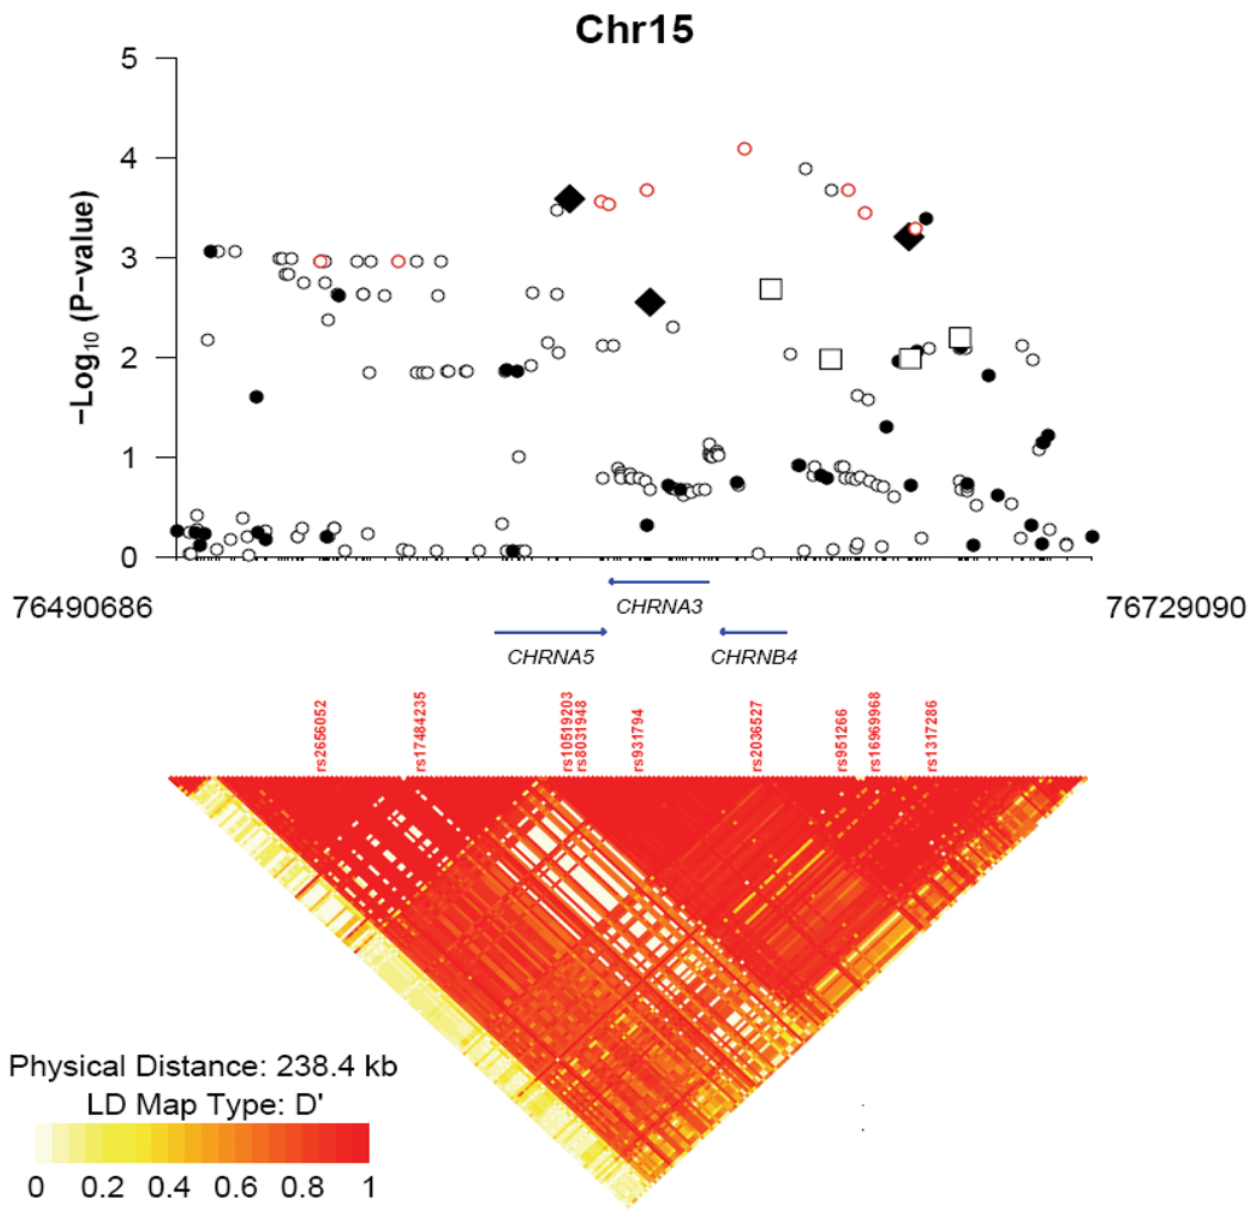
Figure 3. 2 log 10 p-values for association with number of cigarettes smoked per day (CPD) for SNPs in the chr15q25.1 region. P- values are based on the combined evidence for association from both PLCO and NHS. Filled symbols denote genotyped SNPs; open symbols denote imputed SNPs. Black diamonds (squares) denote SNPs associated with continuous (binary) CPD in previous reports. Red circles denote SNPs associated with lung cancer in previous